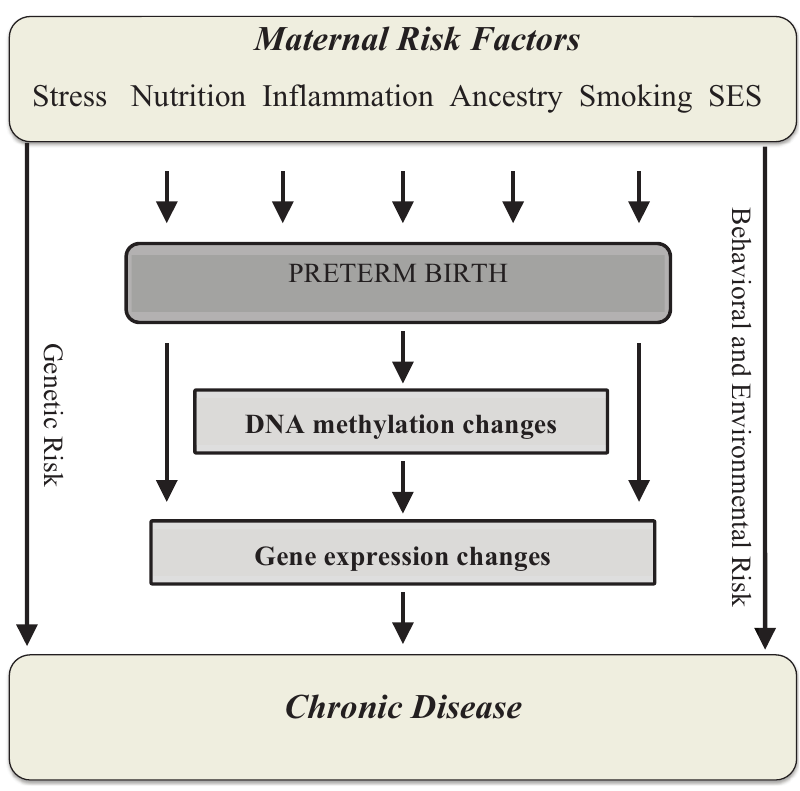
Figure 1. A model for the involvement of DNA methylation in the development of chronic disease following preterm birth (PTB). Multiple maternal risk factors can increase risk of PTB through independent biological mechanisms that may produce changes in DNA methylation or other epigenetic mechanisms. Such risk factors include, but are not limited to, stress, nutrition, immune conditions that produce inflammation, ancestry, smoking and socioeconomic status (SES). These epigenetic changes influence gene expression and thus the developmental trajectory of the neonate. Risk of developing chronic diseases may also be influenced by genetic predisposition and independent behavioral or environmental factors. Maternal Risk Factors Stress Nutrition Inflammation Ancestry Smoking SES